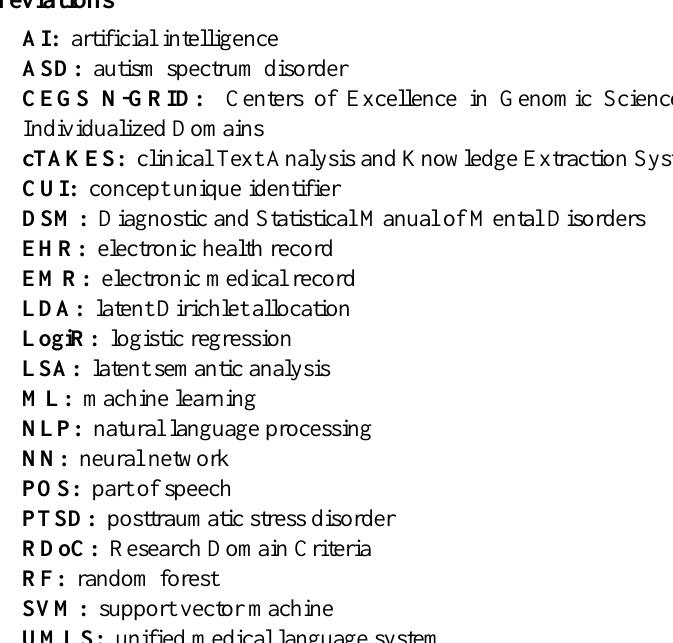
CEGS N-GRID: Centers of Excellence in Genomic Science Neuropsychiatric Genome-Scale and